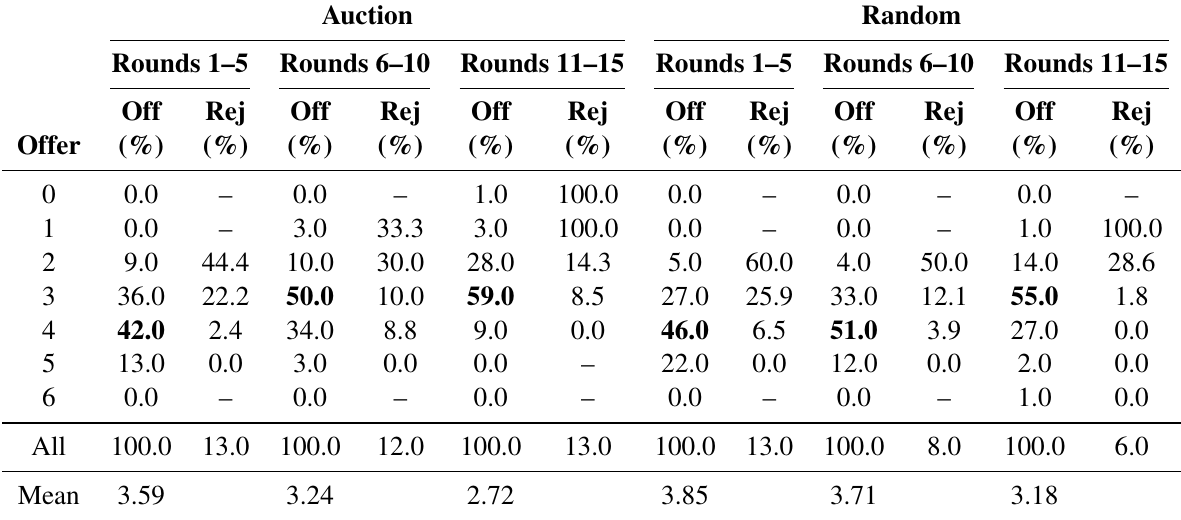
Table 3. Gross offer distributions, conditional rejection rates, and basic statistics over blocks of five periods.